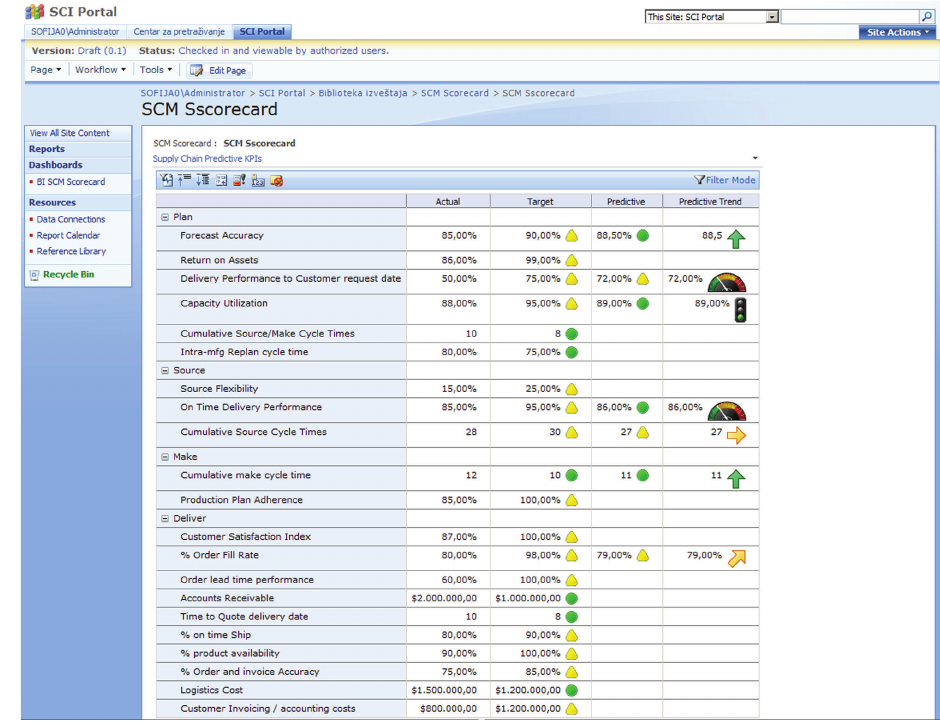
Figure 7: Supply chain scorecard with predictive